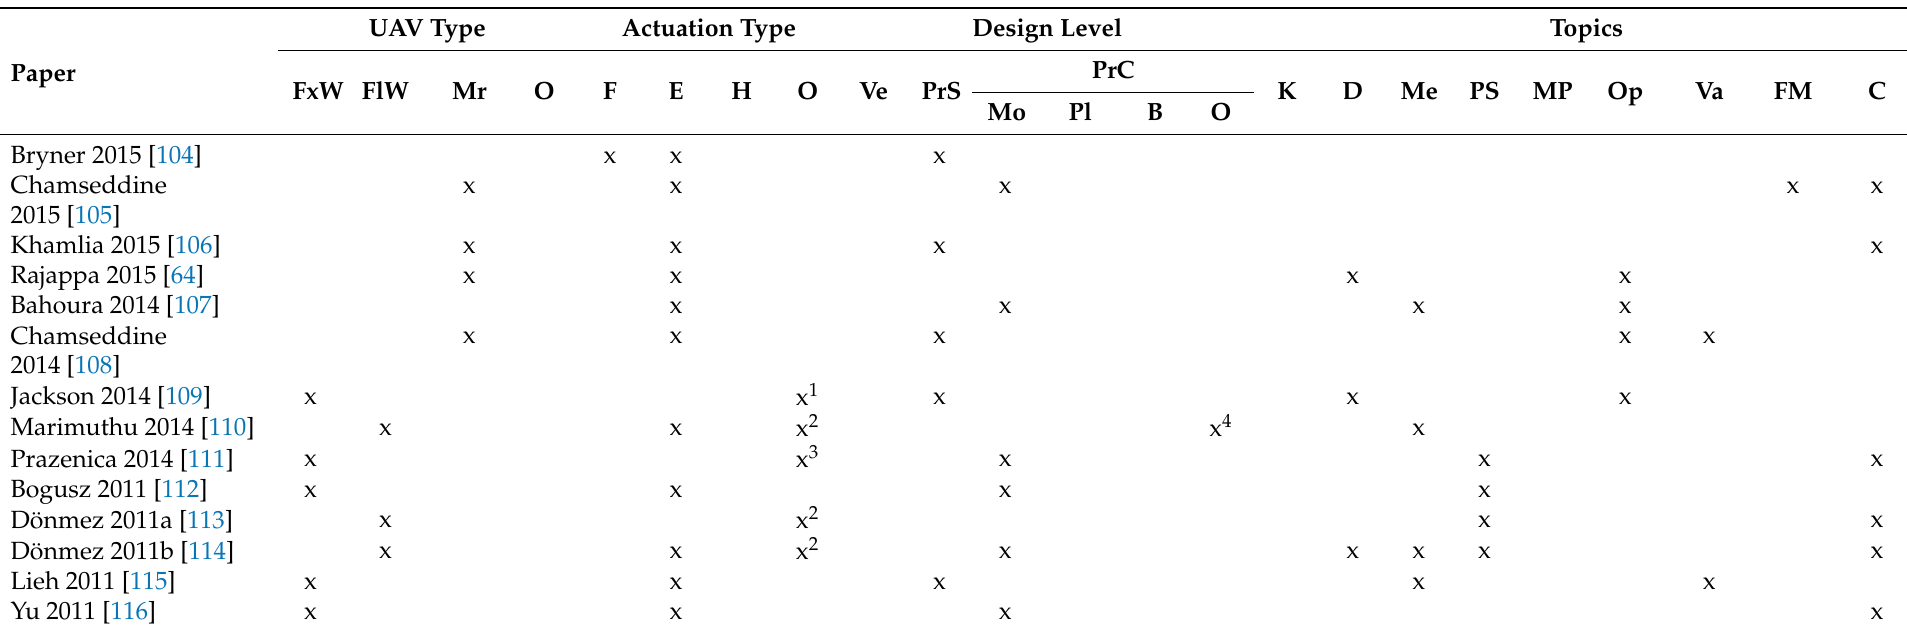
Table 10. Evaluation of the papers categorized in the detailed design category from 2011 to 2015, according to the taxonomy referring to the paper content.